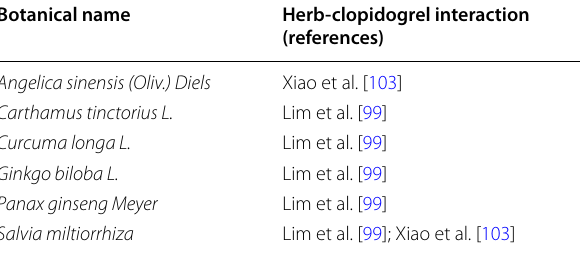
Table 5 List of herb-clopidogrel interaction causing increased risk of bleeding